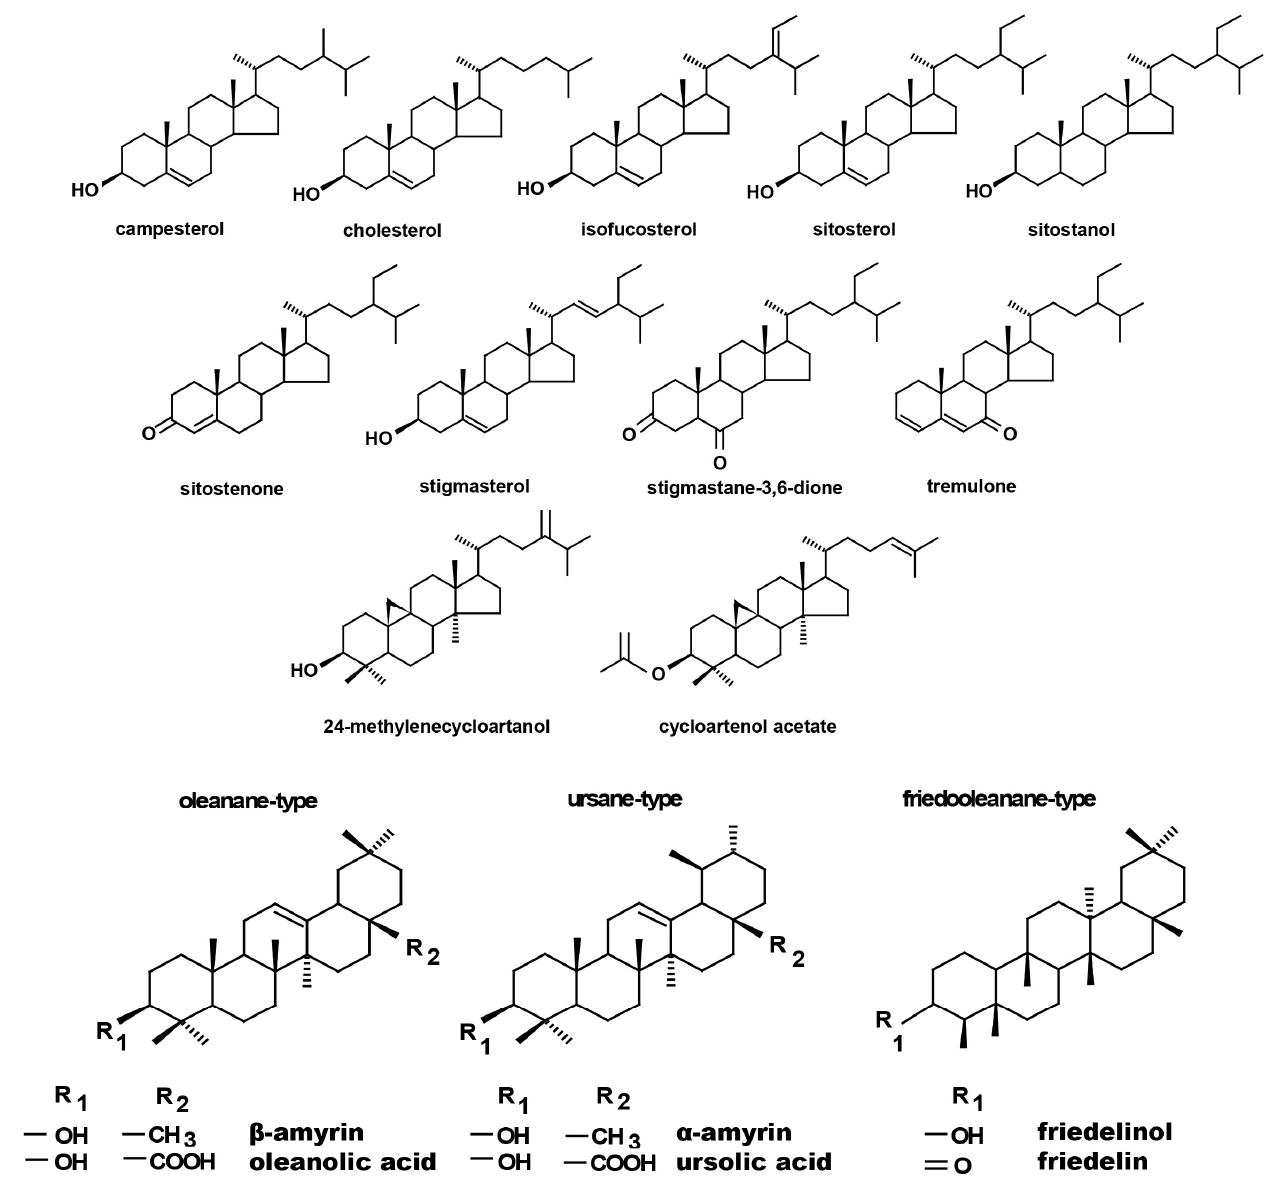
Figure 4. Chemical structures of compounds identified in hairy roots and native marigold plants described in this study.